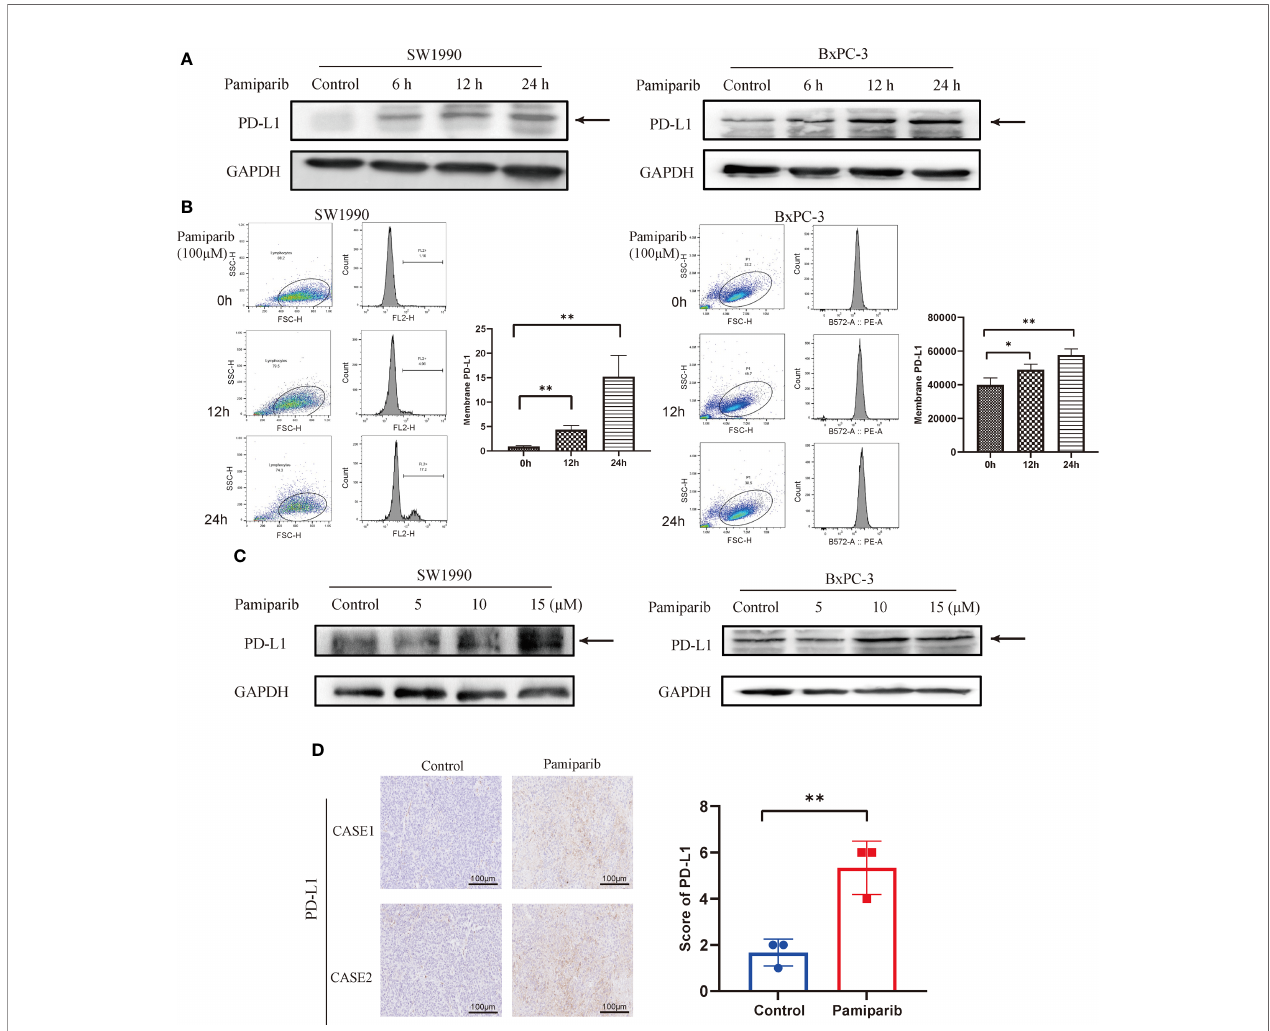
FIGURE 3 | Effects of pamiparib treatment on PD-L1 expression. (A) SW1990 and BxPC-3 cells were treated with pamiparib, proteins were extracted at selected time points (0h, 6h, 12h, 24h), and PD-L1 protein expression was found to be up-regulated by immunoblotting. (B) Flow cytometry detection of PD-L1 expression on the surface of SW1990 and BxPC-3 cells after pamiparib treatment for different times. The fl ow cytometry results were analyzed by unpaired t-test. (C) PD-L1 protein expression was detected by immunoblotting after treatment of SW1990 and BxPC-3 cells with different concentrations of pamiparib for 24h (0, 5, 10, 15 m M). (D) PD-L1 expression showed signi fi cant differences under IHC staining in control and nude mouse xenograft tumors treated with pamiparib. Control, control group; pamiparib, pamiparib monotherapy group. Data are mean ± SD; n = 3 samples per group. Scale bar, 100 m m. The IHC results were analyzed by Pearson c 2 test. * P < 0.05, ** P <